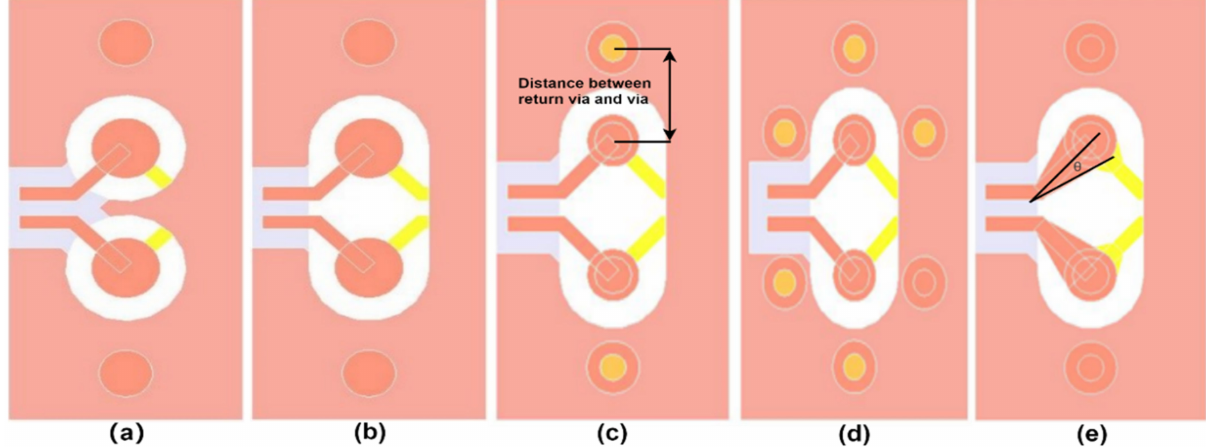
Figure 7. ( a ) Simulation modeling diagram of circular reverse pad; ( b ) simulation modeling diagram of joint reverse pad; ( c ) simulation modeling diagram of two return vias; ( d ) simulation modeling diagram of eight return vias; ( e ) via tear drop simulation modeling diagram.